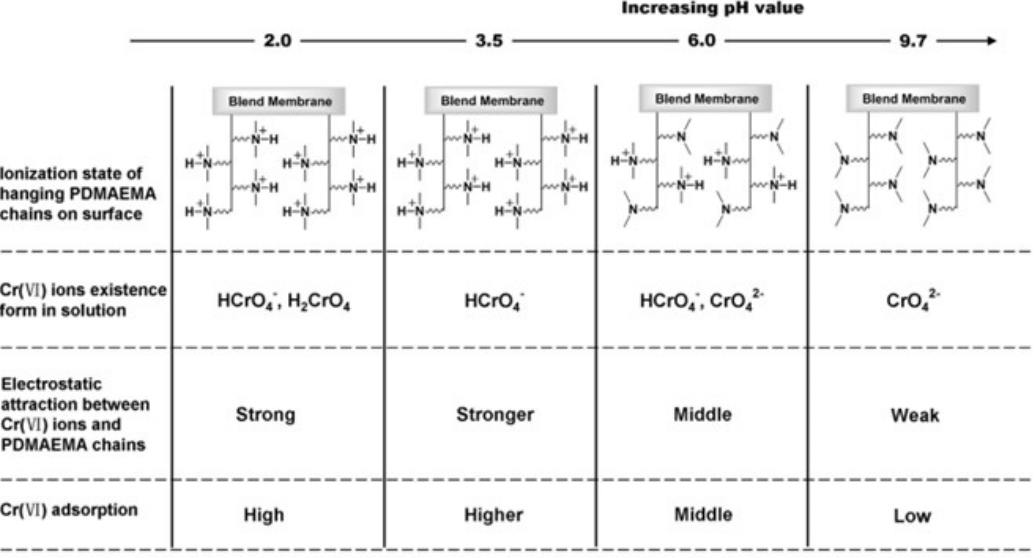
Figure 14. Illustration of ionization state of hanging PDMAEMA chains on membrane surface, and Cr(VI) ion existence forms in solution at various pH values and corresponding electrostatic attraction and adsorption. Reproduced with permission from [166], copyright of Elsevier B.V.